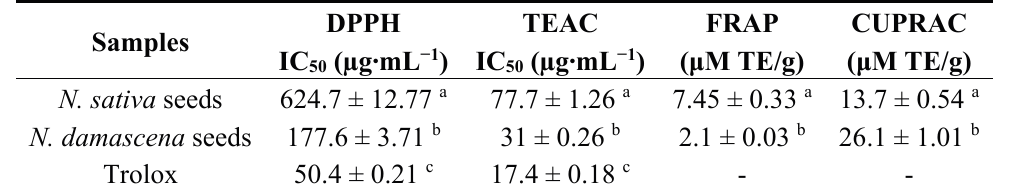
Table 3. Antioxidant capacity parameters obtained using several methods for studied